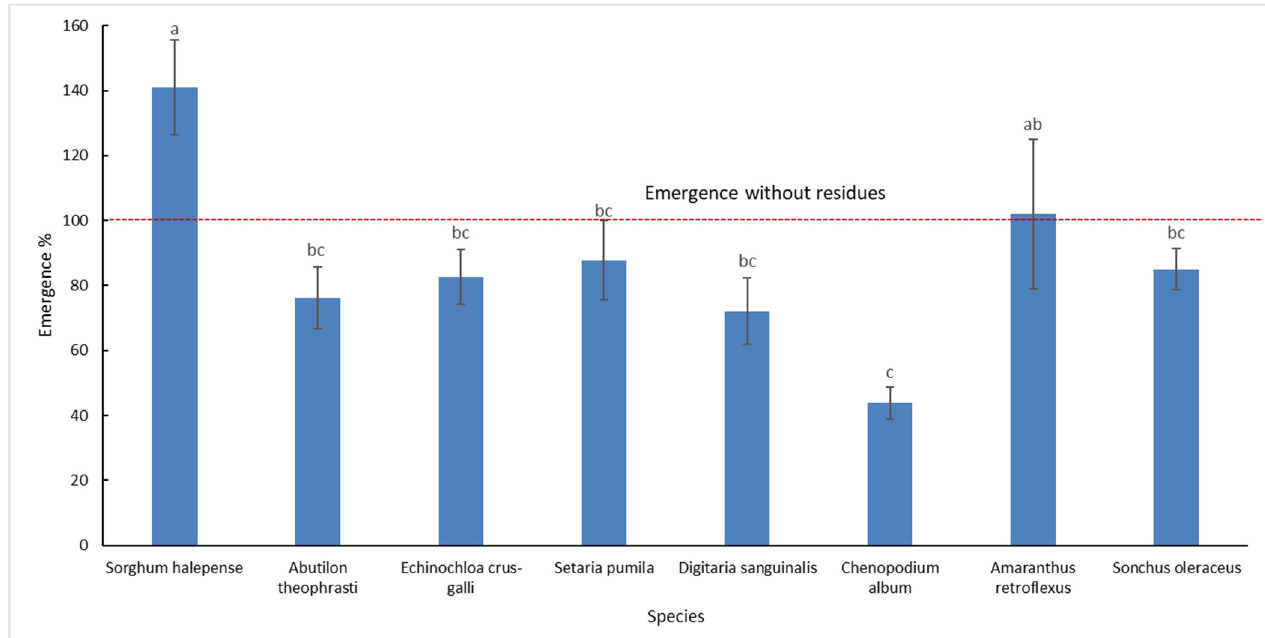
Figure 3. Differences in emergence between weed species in the presence of crop residues. The emergence is expressed as a percentage relative to control (no residues). Emergence values are means of the two types of residues (wheat and maize) and three levels (0.5, 1, and 1.5) of residues quantities. Different letters indicate significant difference ( p -value < 0.05), and the bars indicate the standard error.